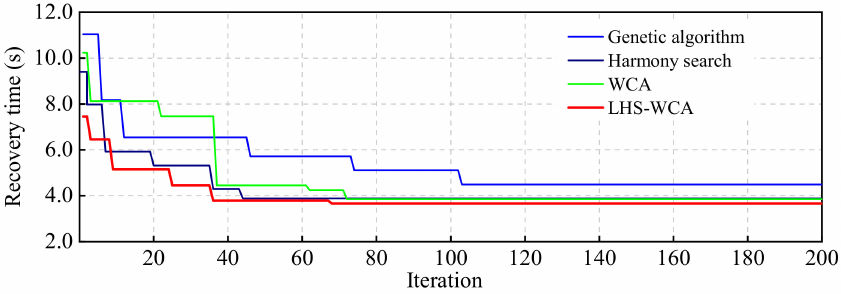
Figure 13. Comparison of the search speed between the LHS-WCA and other optimization